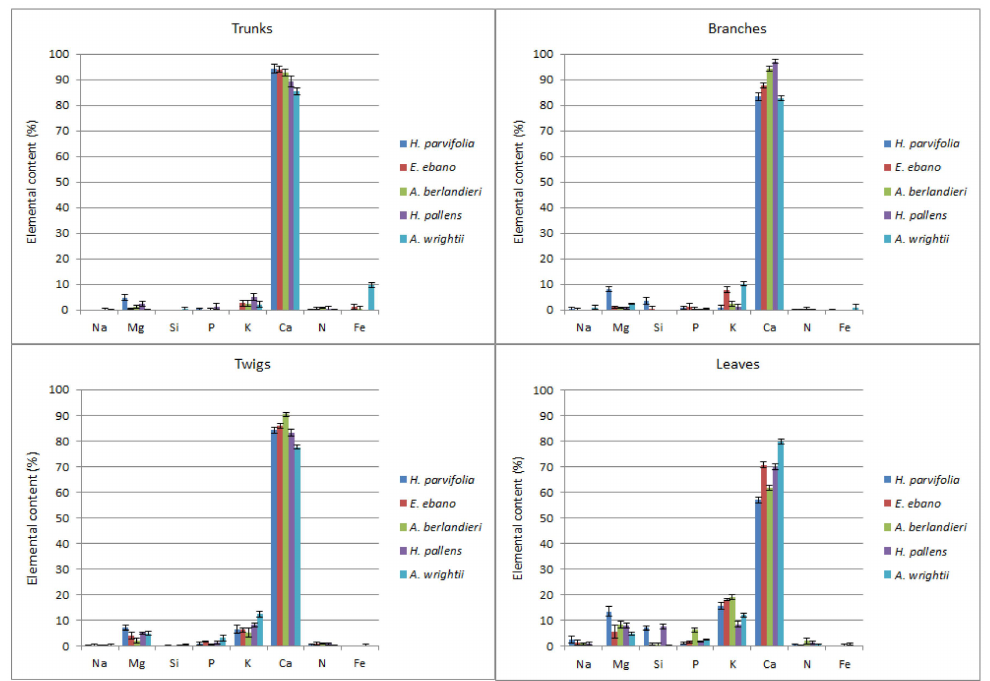
Figure 2. Mineral elements content (%) of five planted timber species of the Mexican semi-arid land in different biomass components (trunks, branches, twigs and